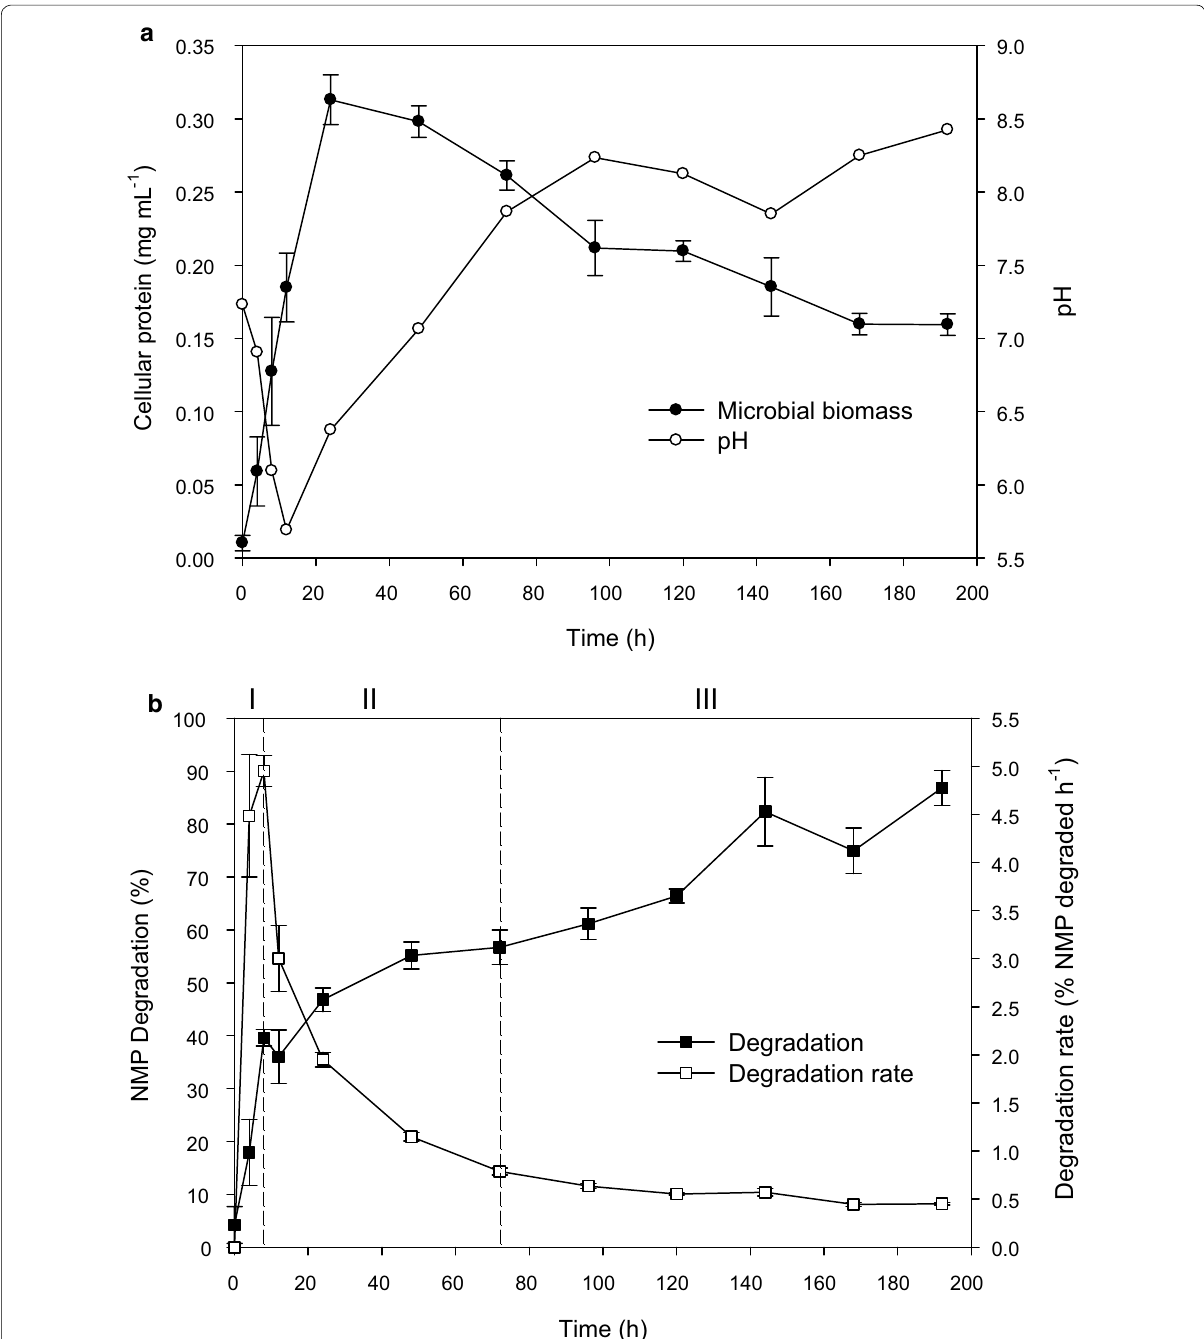
Fig. 1 NMP solids consumption, cellular protein concentration and pH profiles. PM‑06 growth in terms of cellular protein concentration and pH dynamics ( a ). NMP consumption in terms of the percentage of weight loss and degradation rates ( b ). The NMP degradation stages are indicated with the roman numerals I, II and III on the top of the